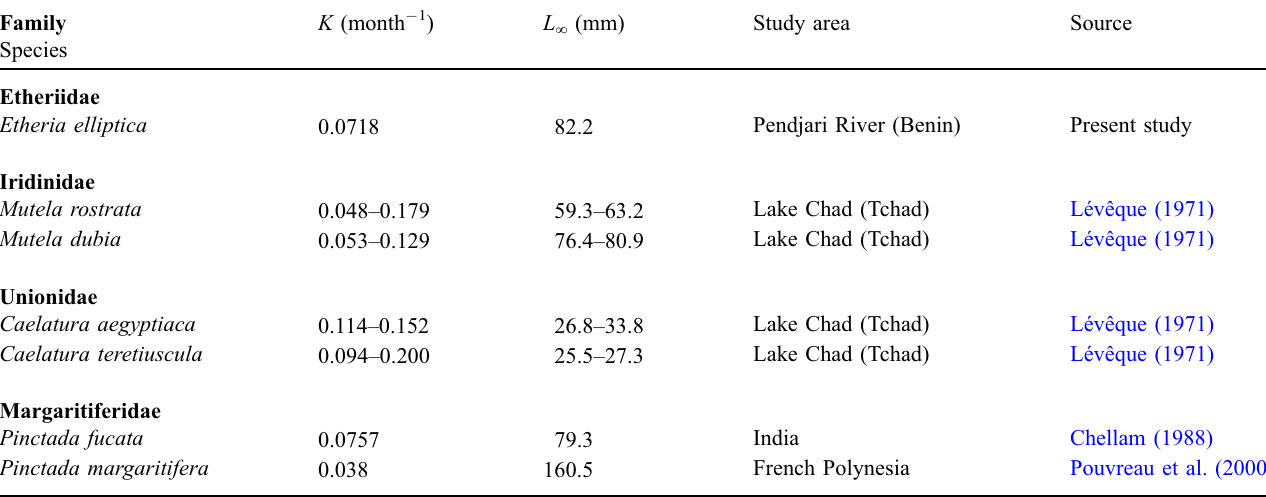
Table 2. Values of von Bertalanffy growth parameters of freshwater mussels (Unionoida) belonging to the Etheriidae, Iridinidae and Unionidae